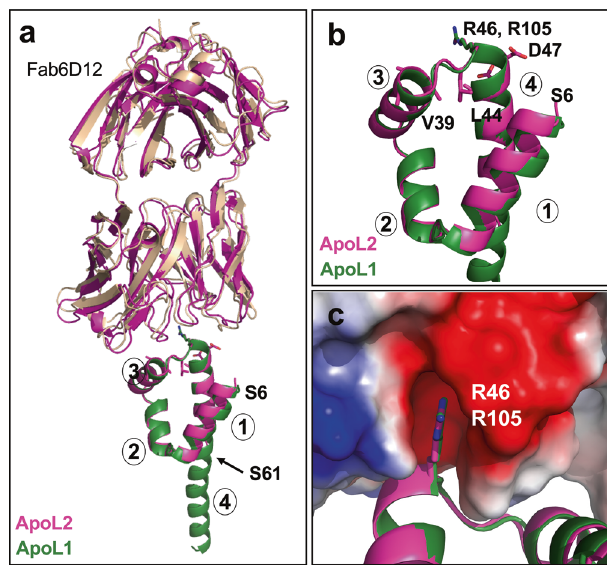
Fig. 7 Structure of the Fab6D12:ApoL2-NTD complex. a The ApoL2-NTD (residues S6 – S61; magenta) in complex with Fab6D12 (magenta) superimposed with ApoL1-NTD (dark green) in complex with Fab6D12 (brown) with key epitope residues as sticks. b Close-up view showing the almost identical structure of the four-helix core regions (helices 1 – 4 are indicated) between ApoL2 (magenta; starting with residue S6) and ApoL1 (dark green). ApoL2 epitope residues are shown as sticks; the key contact residue R46 superimposes with the corresponding R105 residue of ApoL1 (dark green stick). c The key contact residue of ApoL2 (R46, magenta stick) and of ApoL1 (R105, green stick) superimpose perfectly and insert into the identical acidic pocket of the Fab6D12, which is shown in surface representation and colored according to approximate net electrostatic potential (blue, positive; red,